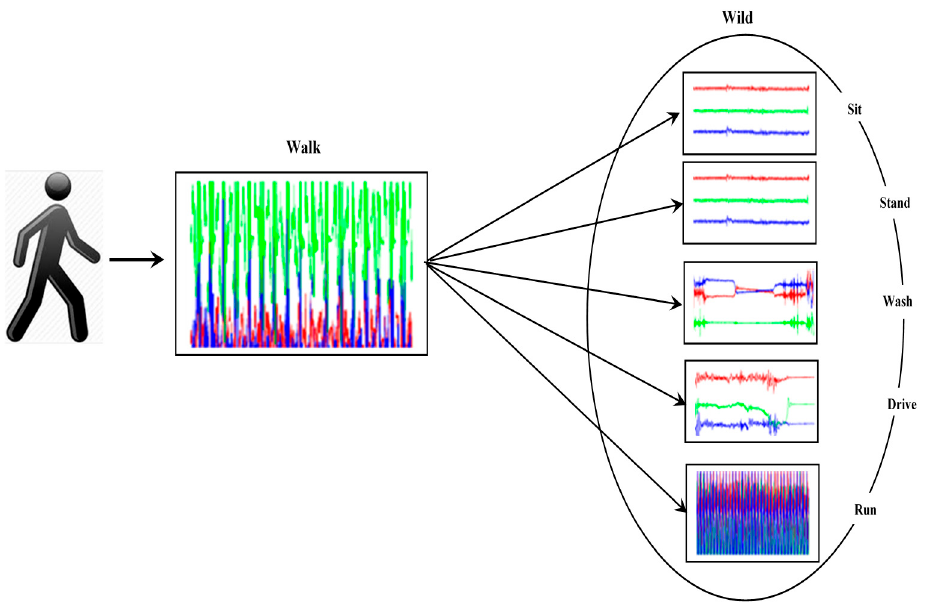
Figure 5. Walk to wild.